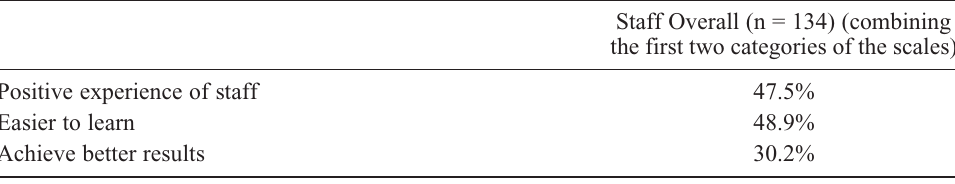
Table 1. Percentage of lecturers’ agreements on their overall experience with WBLT, and the benefits of WBLT on aspects of student learning.